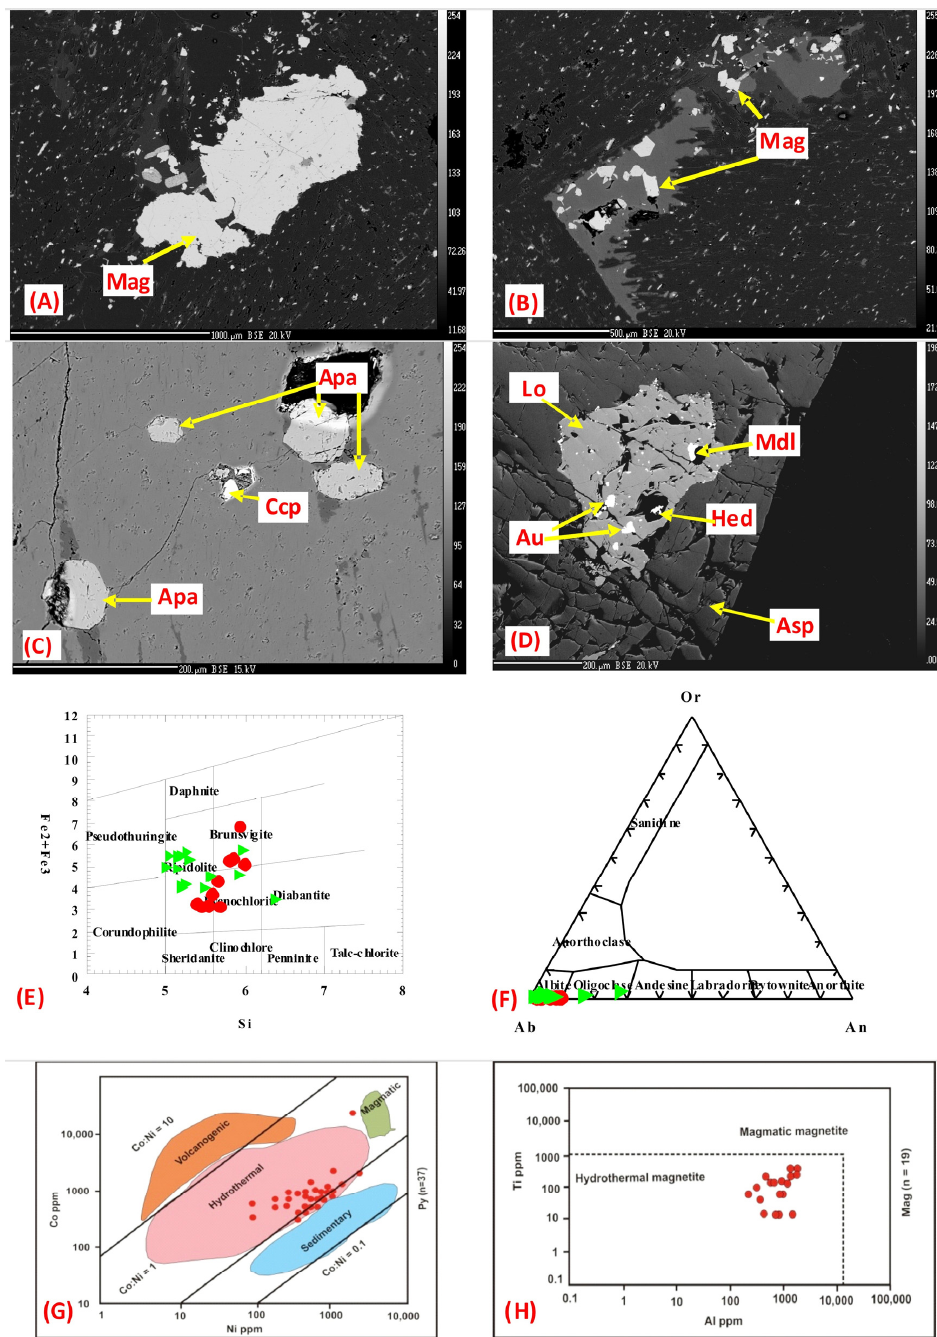
Figure 8. BSE images of magnetite-apatite-gold-sulfide mineral assemblages along with plots sug- gesting hydrothermal nature of pyrite and magnetite in the study area. ( A ) Magnetite megacryst in quartz-mica schist; ( B ) Disseminated magnetite within quartz mica-schist; ( C ) Subrounded to rounded apatite grains associated with chalcopyrite; ( D ) Association of gold, loellingite, arsenopyrite, maldonite and hedleyite; ( E ) Mineral composition classification diagram of chlorite, (Red = albitite, green = quartz-mica schist); ( F ) Or-Ab-An classification diagram of feldspar. (Red = albitite, green = quartz-mica schist); ( G ) Co vs. Ni plot of pyrite show hydrothermal signature, fields for pyrite composition from references [64]; ( H ) Ti vs. Al covariation plots of magnetite indicates magnetite is hydrothermal in nature, fields from reference [65]. (Apa = apatite, Mag = magnetite, Ccp = chalcopyrite, Au = gold, Mdl = maldonite, Lo = loellingite, Hed =